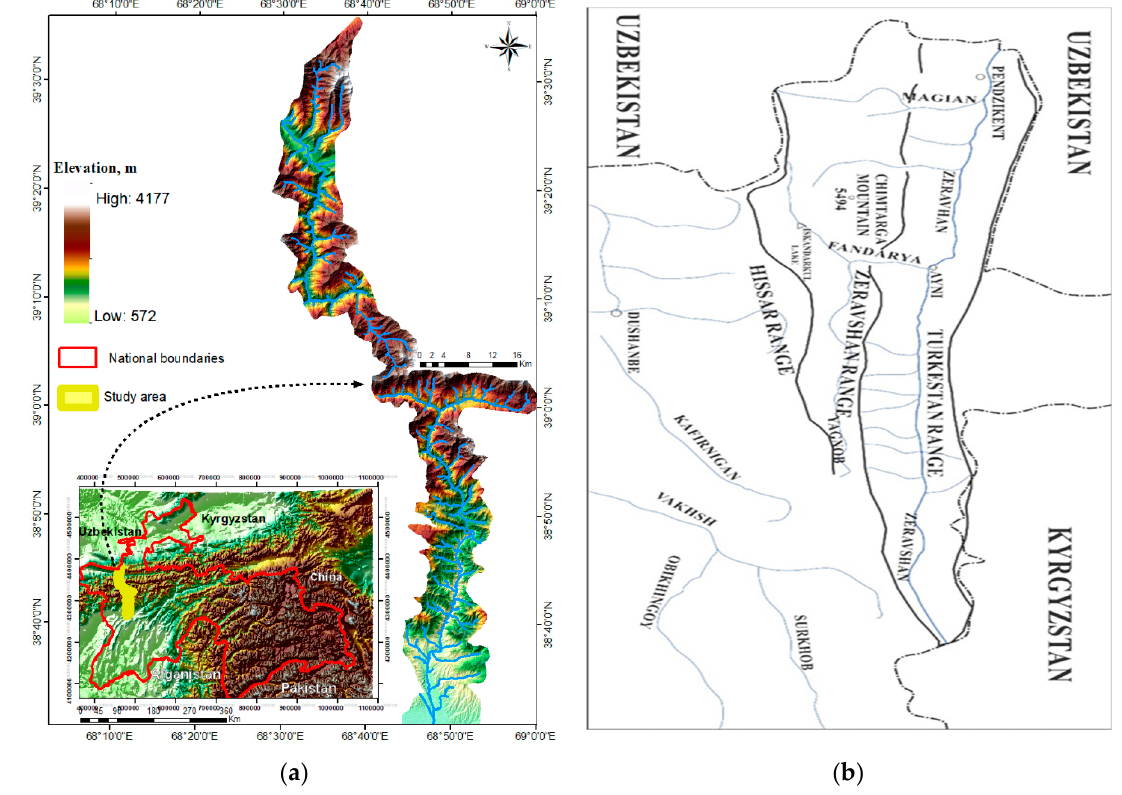
Figure 1. Location map of the study area ( a ), scheme map of the Hissar–Allay region ( b ). Some peaks rise to 4000 m, but average topographical elevation ranges between 700 and 3000 m.a.s.l. (Figure 1a). The landscape includes mountains, uplands, and narrow valleys, consisting of steep rocky slopes shaped by geomorphological processes and hu- man activities. The terrain elevation, aspects, and slope gradients derived from DEM mostly face S-SW (Figure 2).